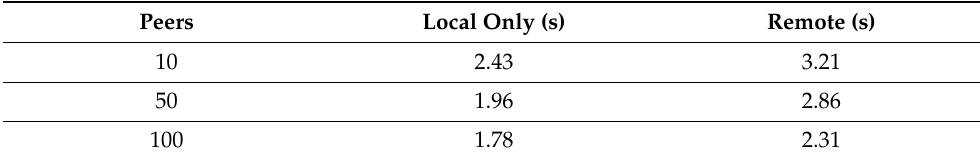
Table 2. Evaluation result of places 10, 50, and 100 peers in a single